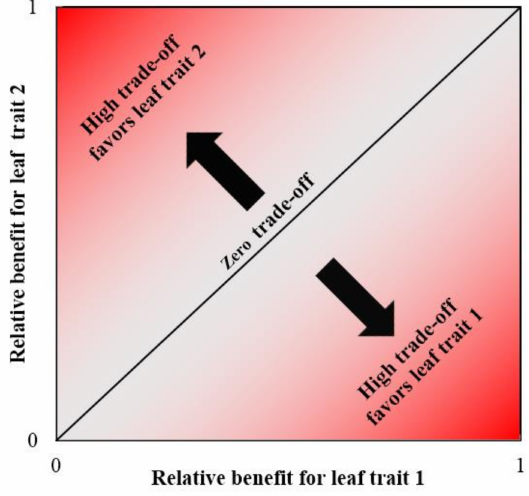
Figure 1. Illustration of trade-off between two leaf traits